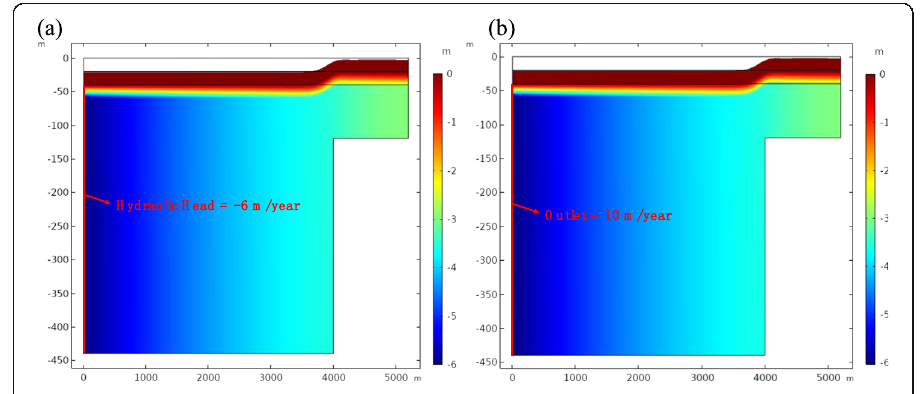
Fig. 14 Effects of the boundary conditions on the deterministic results. a Hydraulic head boundary condition. b Flux boundary condition